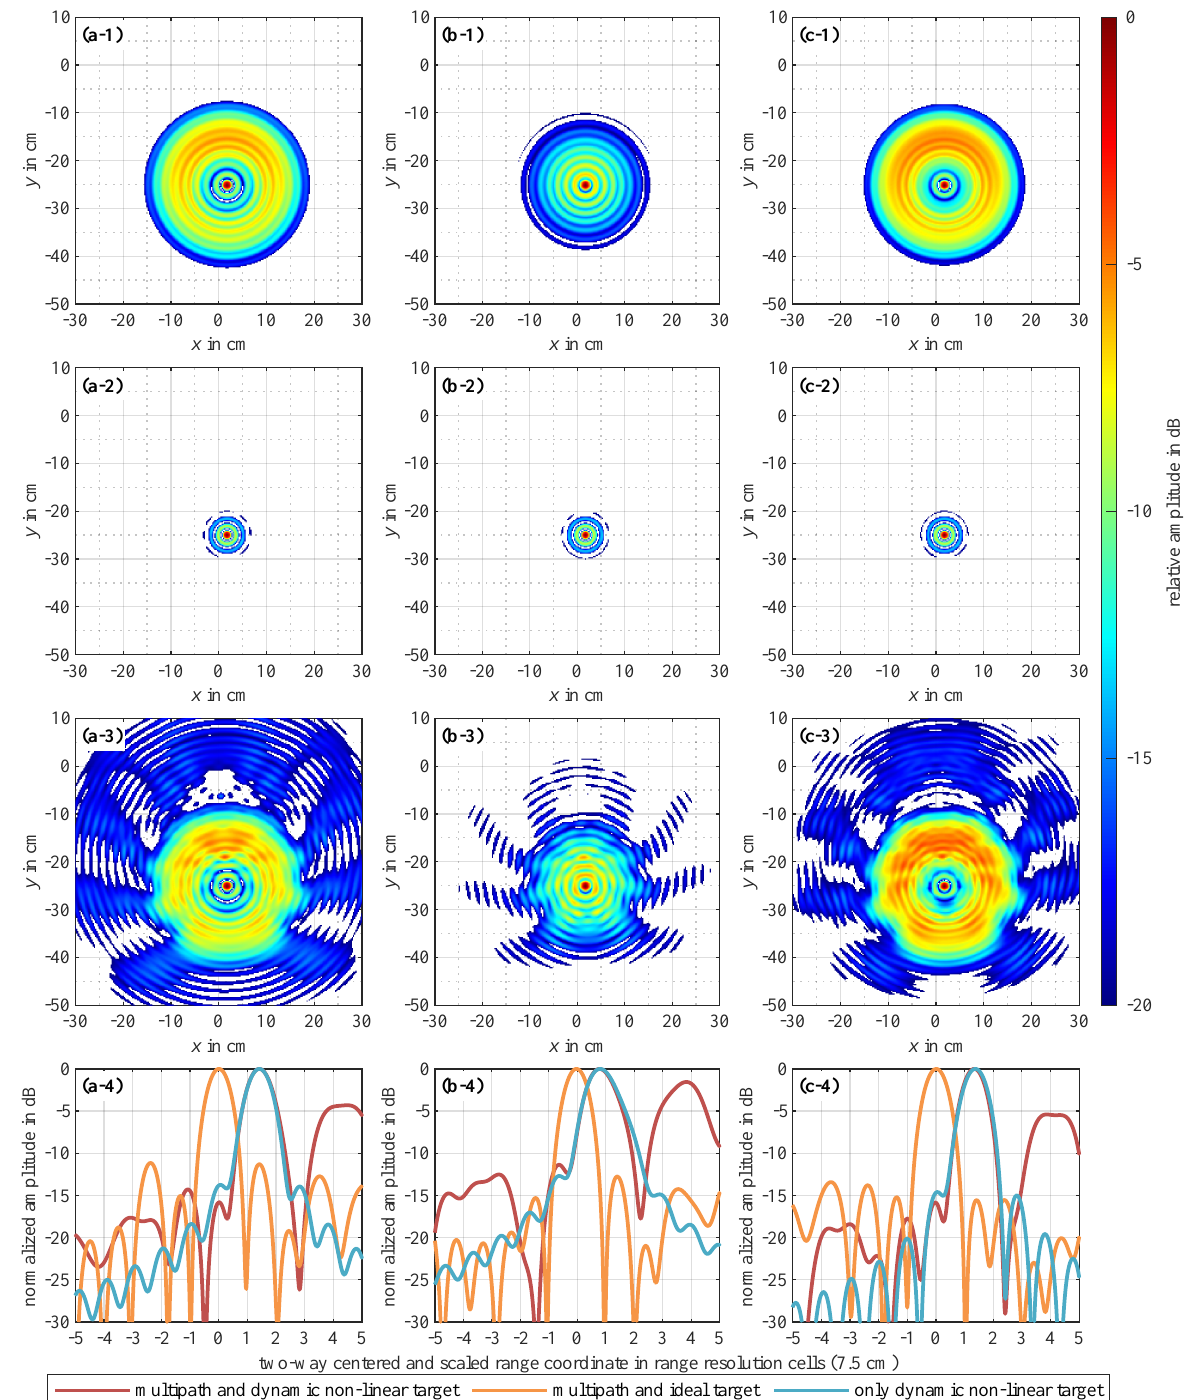
Figure 4. Comparison of three randomly generated simulation scenarios with ( a,b,c-1,2,3 ) xy –plane maximum projections and ( a,b,c-4 ) selected range-profiles. A detailed description can be found in corresponding explanations in Section 4.3. The different simulation instances in Figure 4 are indicated by (a-1,2,3), (b-1,2,3) and (c-1,2,3). All images (a,b,c-1,2,3) show maximum projections in the xy –plane, with each image being normalized to the respective maximum image value using a logarithmic scaling, normalized to the respective image maxima and a dynamic range of 20 dB.